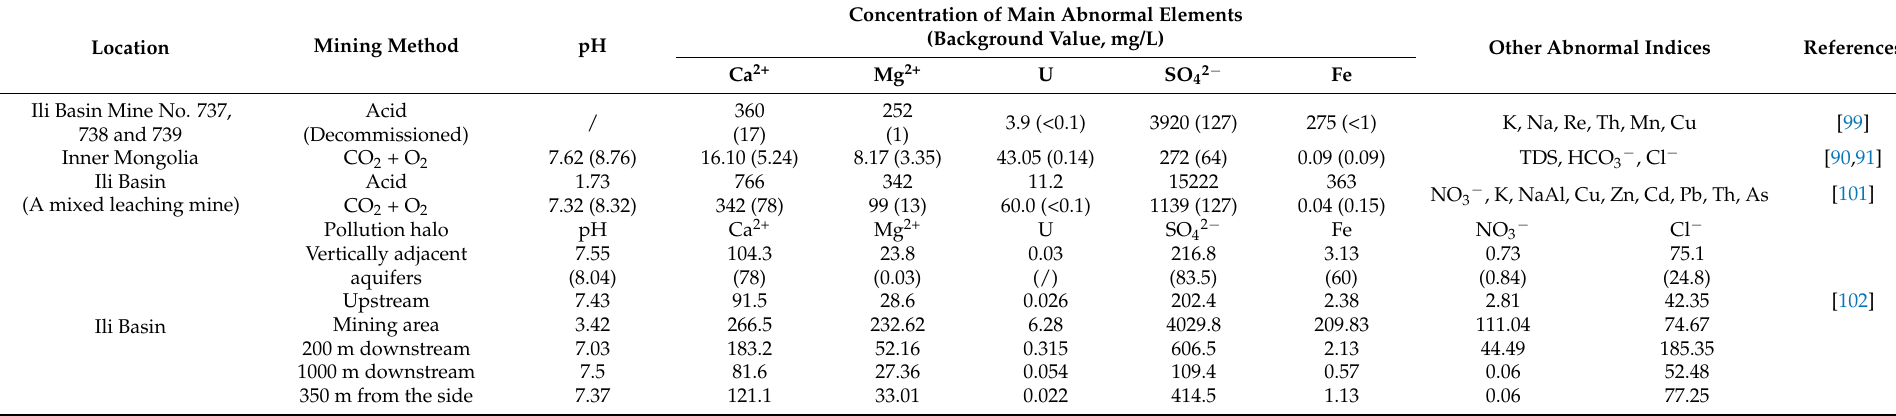
Table 3. Hydrochemical anomalies in some representative mining